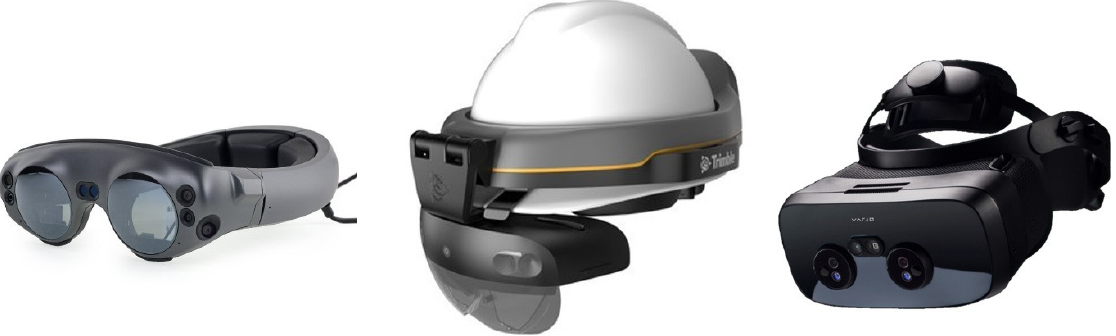
Figure 4. Magic Leap 1 ( left ), MS HoloLens 2 on Trimble (Sunnyvale, CA, USA) XR10 ( center ), and Varjo XR-3 ( right ).